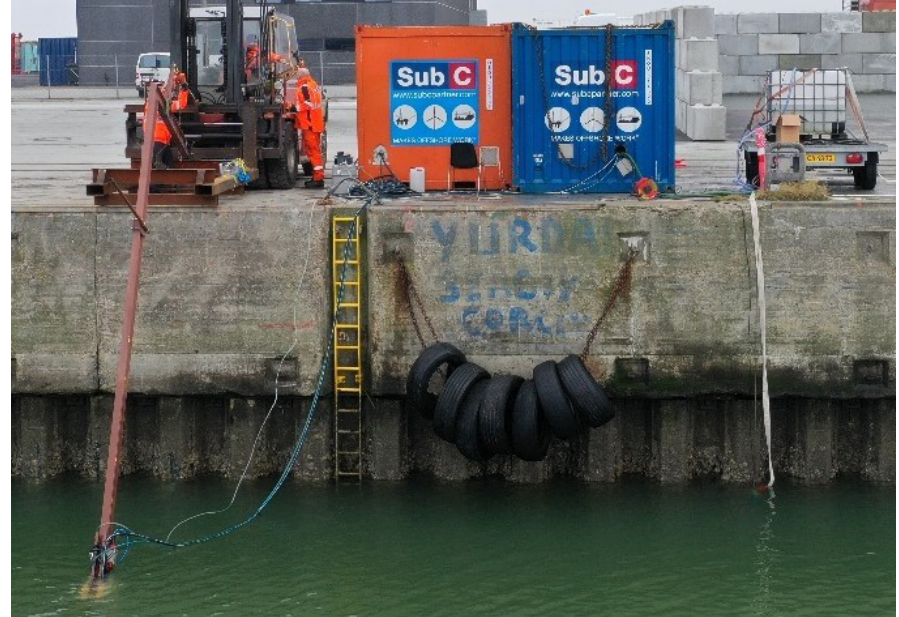
Figure 4. Test setup for cleaning test at Port of